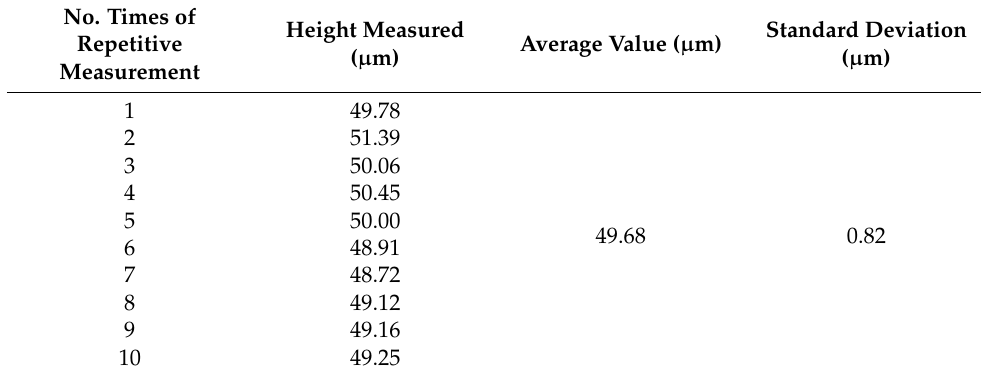
Table 2. Repeatability of measurements taken 10 times for each micro bump. No. Times